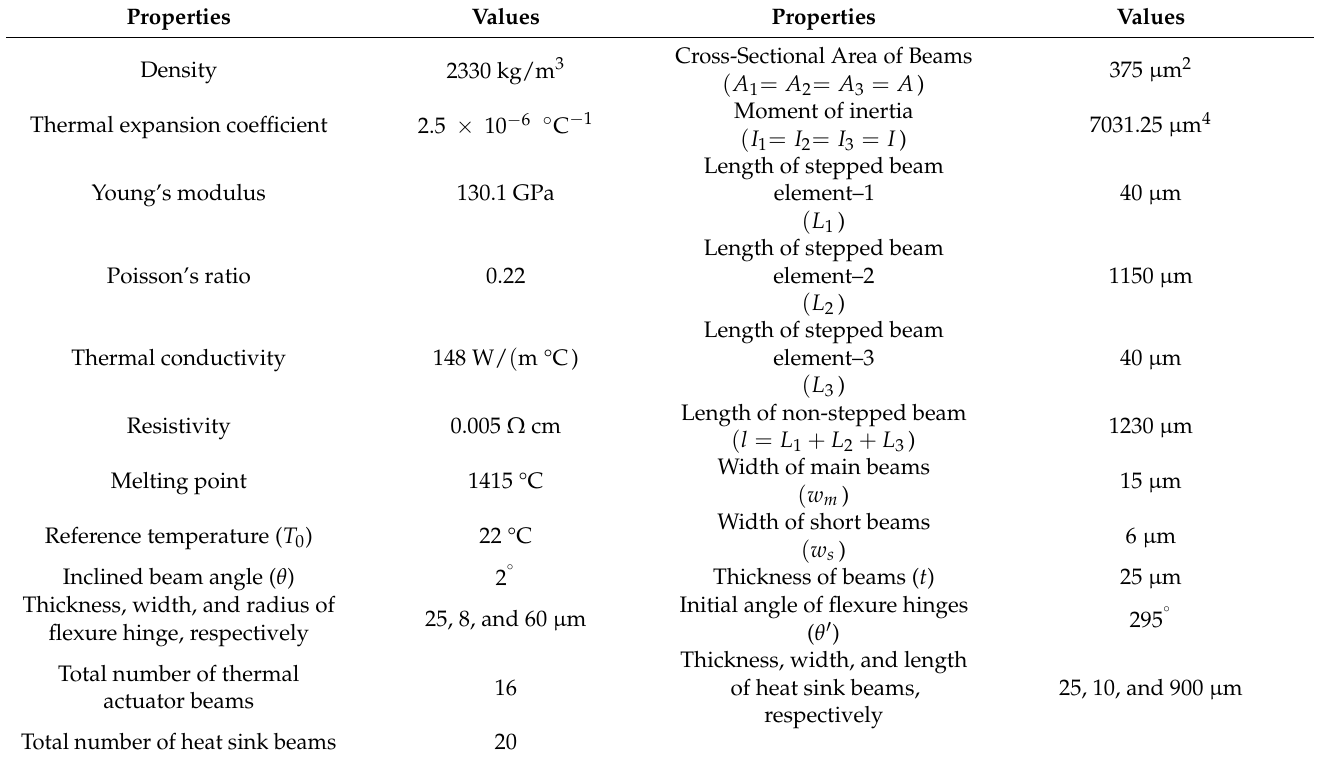
Table 1. Silicon properties [40] and geometrical